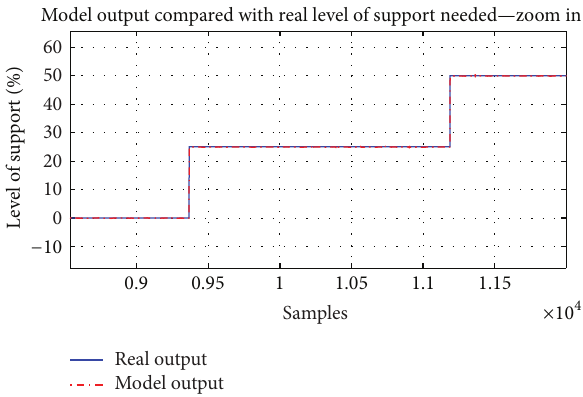
Figure 10: Modelling of the support function of the orthosis, enlarged